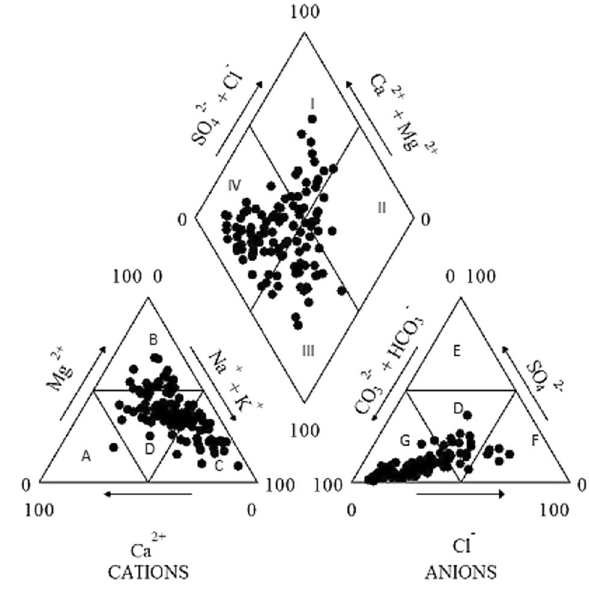
Fig. 9 Hydrogeochemical classification of the groundwater samples from the Markapur region, Prakasam district, Andhra Pradesh,